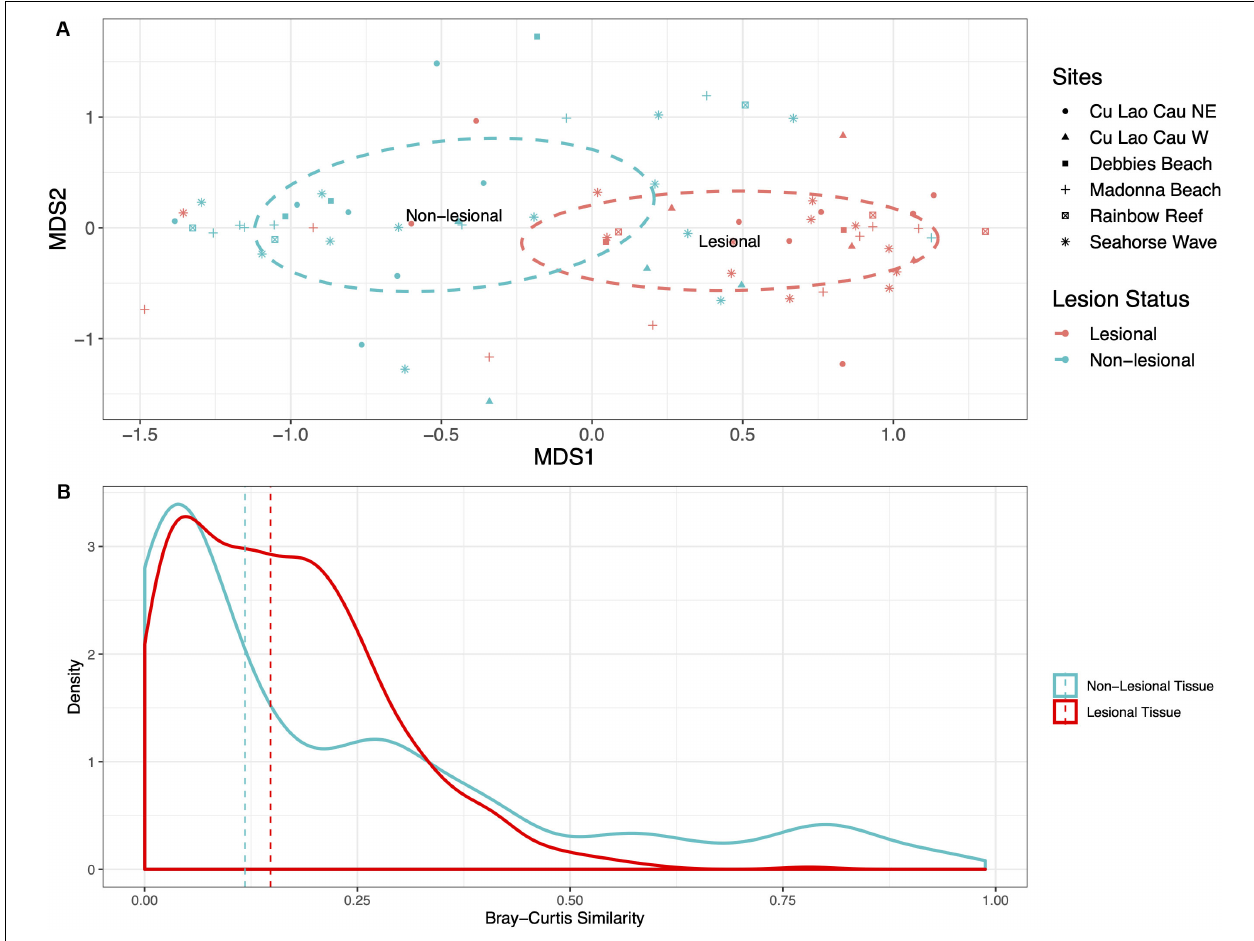
FIGURE 3 | (A) nMDS plot shows data from rarefied Porites data clustering based on lesion status. The dashed circles are representative of the groups’ 95% confidence interval. (B) The Bray-Curtis similarity of the non-lesional and lesional tissue. Lesional tissue contained more similarity in composition with a mean of 0.15 similarity. Whereas, the non-lesional tissue was much more variable, with a mean of 0.12 similarity (the mean is represented by the dashed lines). TABLE 1 | PERMANOVA summary statistics for factors affecting the bacterial composition in non-lesional and lesional corals. Factors Df Sums of squares Mean squares F models R2 P -value Permutation Islands 1 0.535 0.535 1.570 0.0199 Site Residuals 67 Total 73 26.962 1.000 Strata =